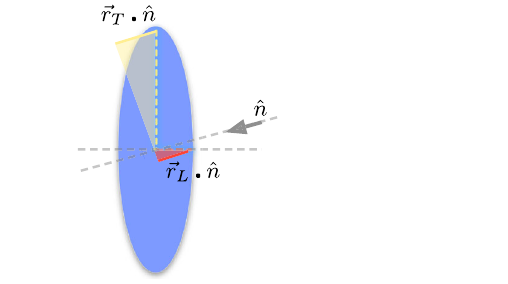
FIG. 4. Schematic of the transverse and longitudinal contrib- uting to the coherence form factor.